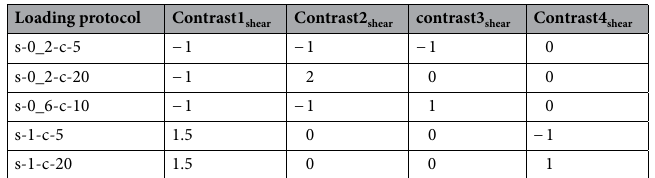
Loading protocol